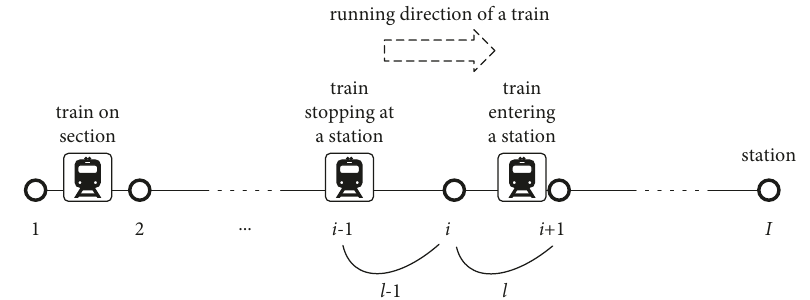
Figure 1: Illustration of a typical URT line.